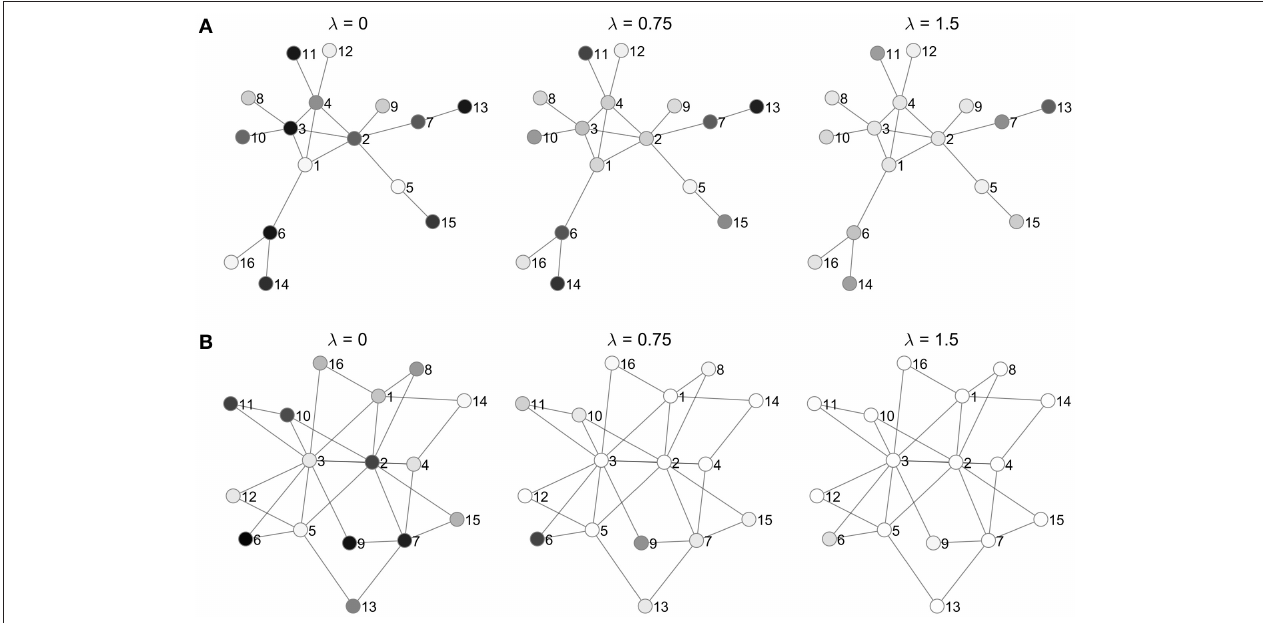
FIGURE 9 | Examples of symmetric ALR models obtained by randomly generating a graph and covariates according to (A) Case 1 and (B) Case 2 as described in the text. Each model is shown for three λ values, to illustrate the neighborhood effect. Nodes are shaded to indicate their marginal probability of taking the high level (lighter shades indicate higher probability).